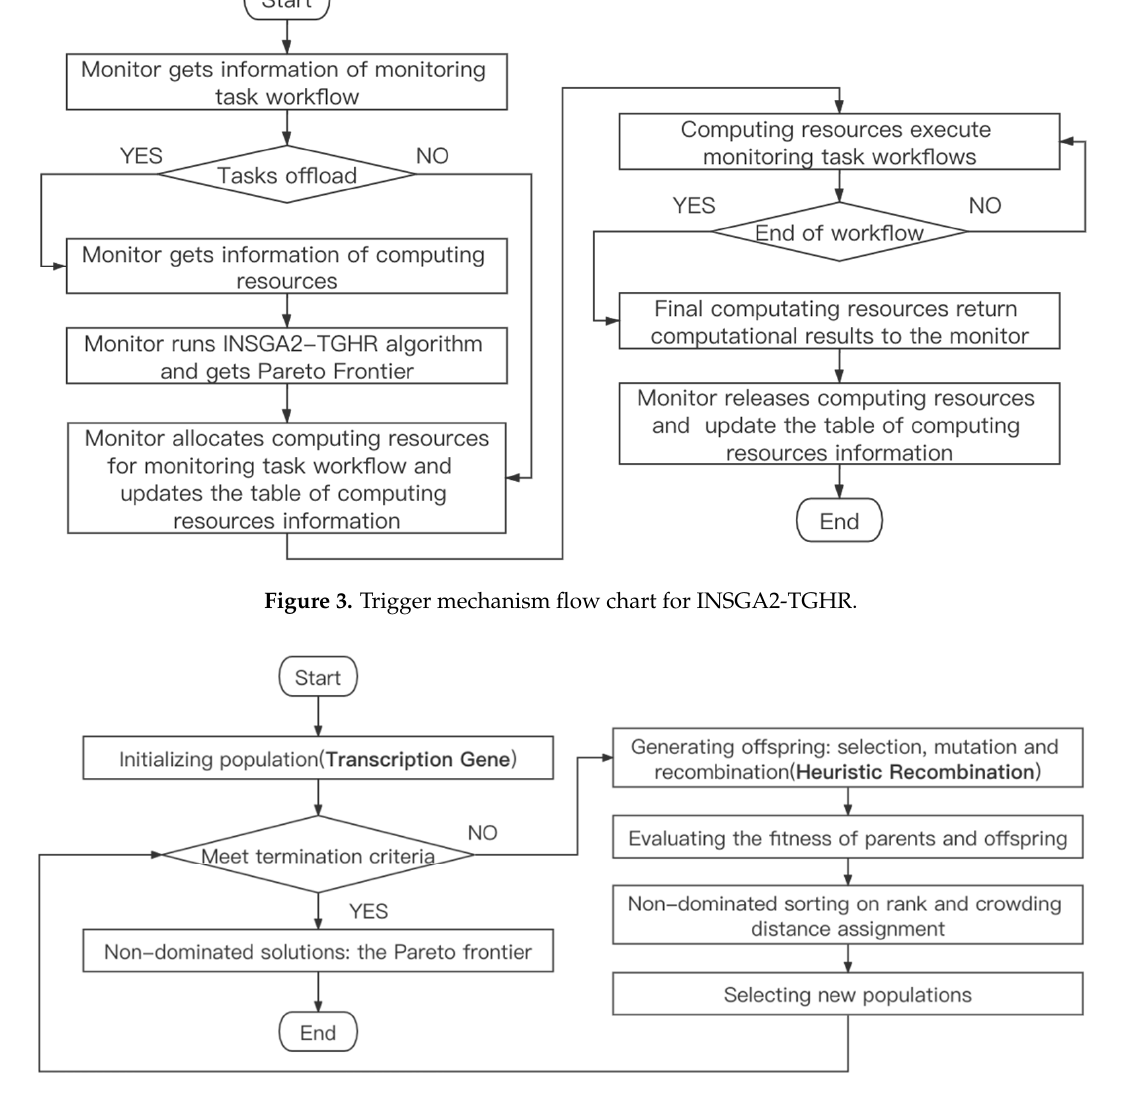
Figure 4. Flow chart of INSGA2-TGHR.